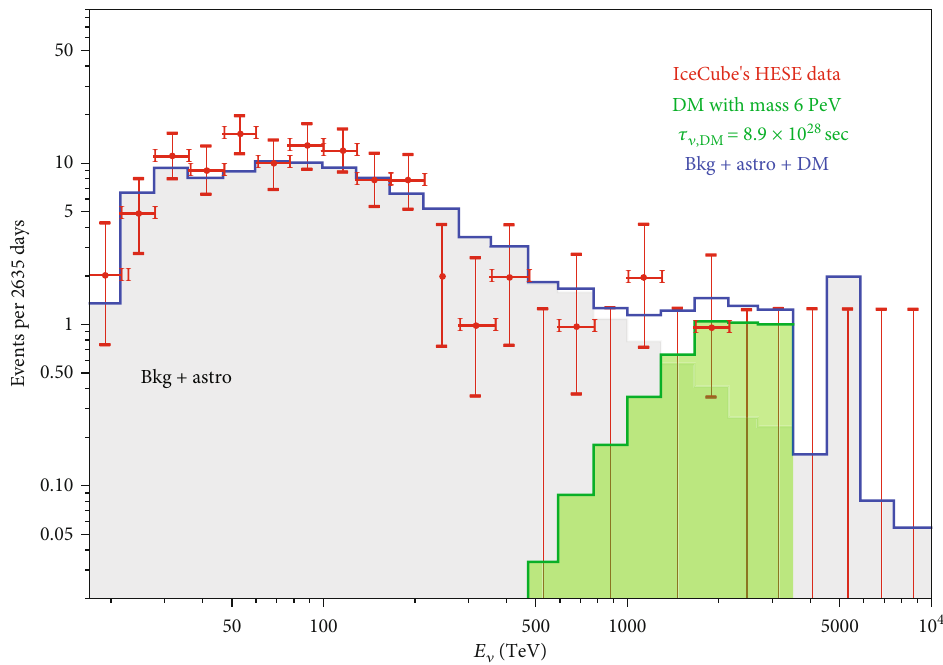
Figure 6: Normalized neutrino event distribution is shown. The contributions to PeV neutrino fl ux from the galactic and the extragalactic DM decay are shown by the green region. The total fl ux from all the sources is shown by the blue